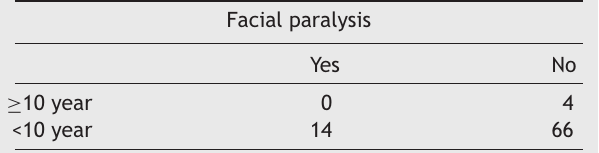
Case-control table --- duration of the disease (10